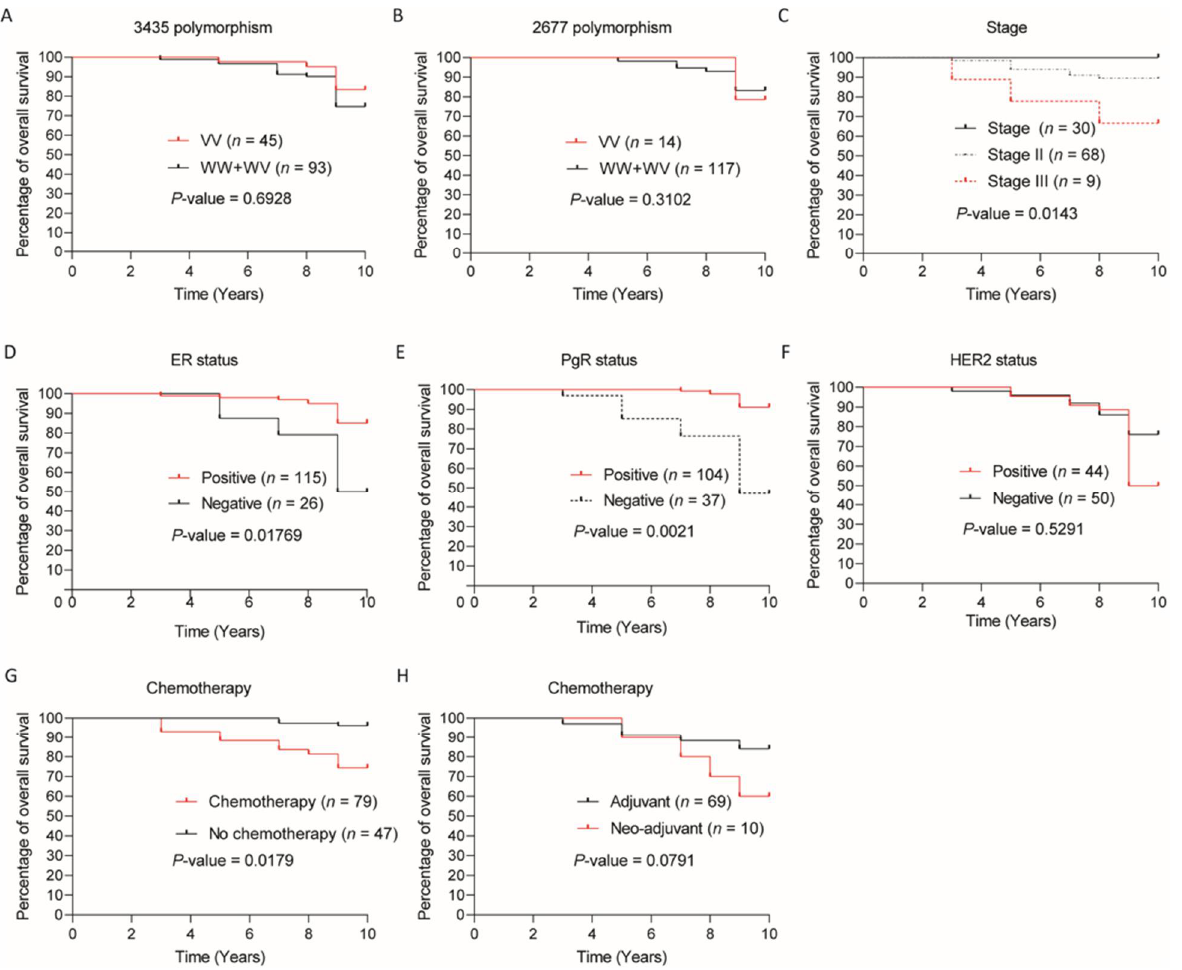
Figure 1. Ten-year survival assessment of breast cancer patients. Kaplan–Meier curves of overall survival of patients with breast cancer for ABCB1 3435 ( A ) and 2677 ( B ) polymorphisms. For each analysis, patients were divided into two groups: with a presence (VV; red line) or absence/heterozygous variant of polymorphisms (WV + WW; black line). ( C ) Kaplan–Meier curves of overall survival of patients with breast cancer in different stages of disease (Stage I—black line; Stage II—green line; Stage III—red line). Kaplan–Meier curves of the overall survival of patients with breast cancer with ER ( D ), PgR ( E ), and HER2 ( F ) receptor status were analyzed; red line—positive, black line—negative. Impact of chemotherapy treatment (( G ) black line—patients treated with chemotherapy; red line—patients non-treated with chemotherapy) and type of chemotherapy (( H ) black line—adjuvant chemotherapy; red line—neoadjuvant chemotherapy) on overall survival was also assessed. All Kaplan–Meier curves were generated using GraphPad Prism (data collected from Xena browser).